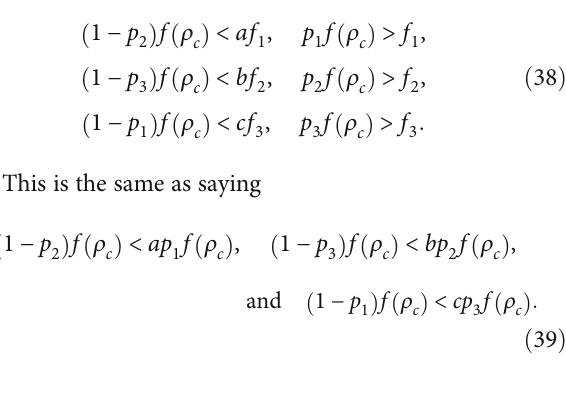
, S , S ) in the case of (c) with corresponding fl uxes as shown in (b) and (d), 2 4 6